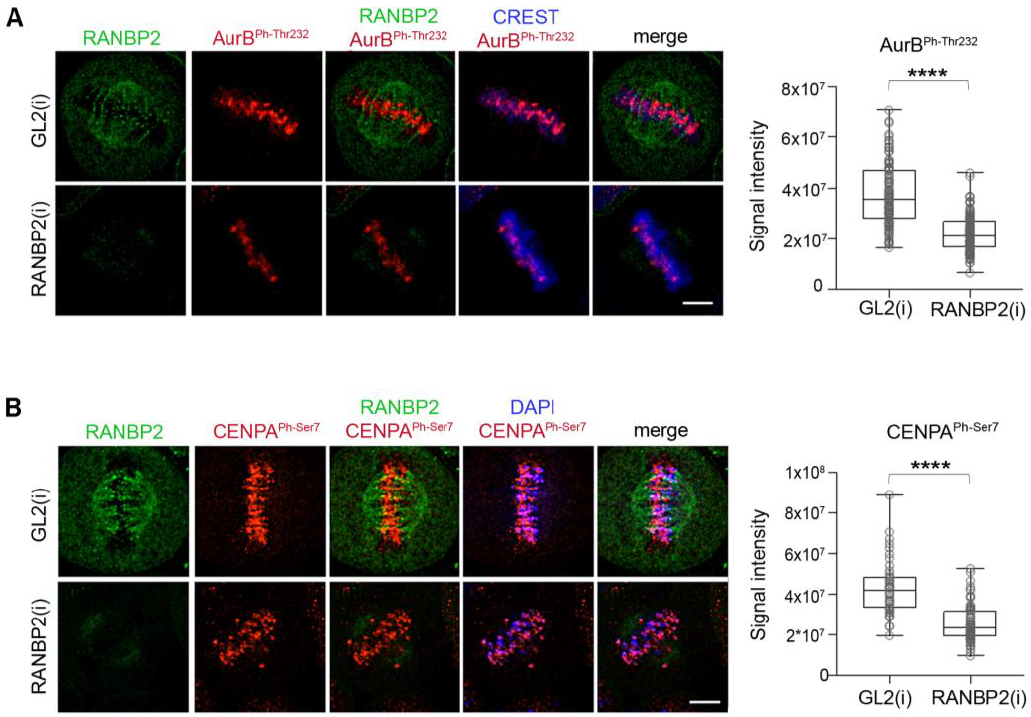
Figure 6. RANBP2 silencing impairs Aurora B autophosphorylation at Thr232 ( A ) and phosphorylation of CENP-A at Ser7 ( B ) at centromeres. Experiments were repeated three times. The quantitative analysis of markers in control (interfered with neutral GL2 siRNAs) and RANBP2-interfered cultures is shown in the box plot and the statistical analysis is as follows: AurB phThr232 (n, 100 for GL2 and 107 for RANBP2), **** p < 0.0001; CENP-A ph-ser7 (n, 45 and 72 cells) **** p < 0.0001.